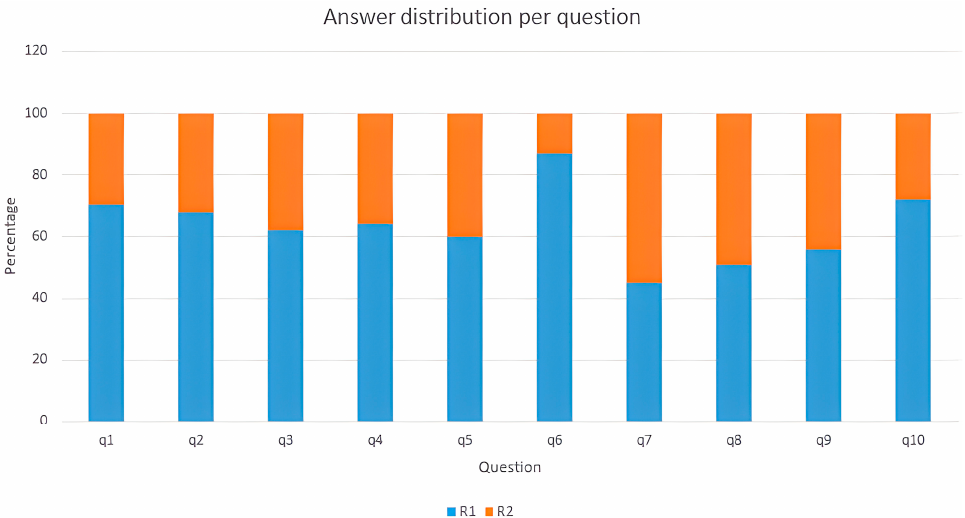
Figure 11. Experiment 2: answer distribution per question, where the y-axis illustrates the percentage of R1 and R2 per question.